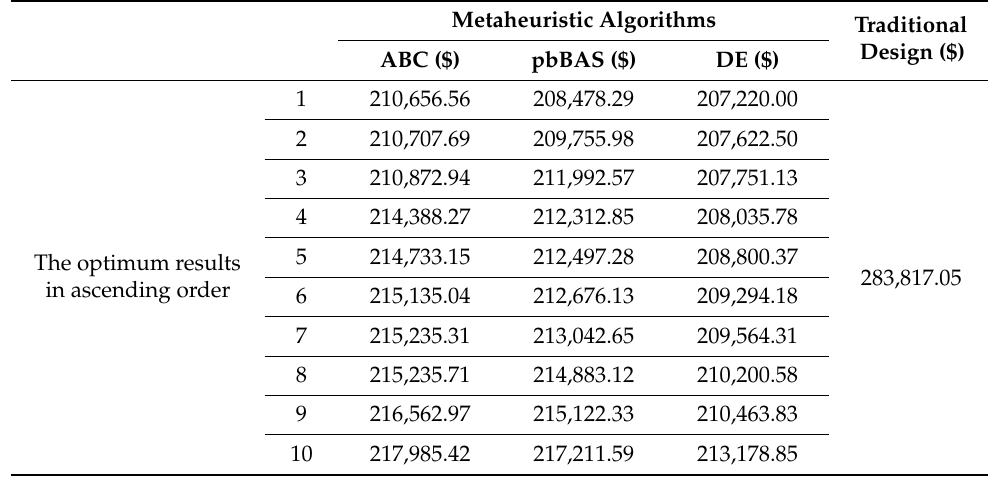
Table 23. Optimum results achieved in the three-segment type folded plate roof building by each metaheuristic